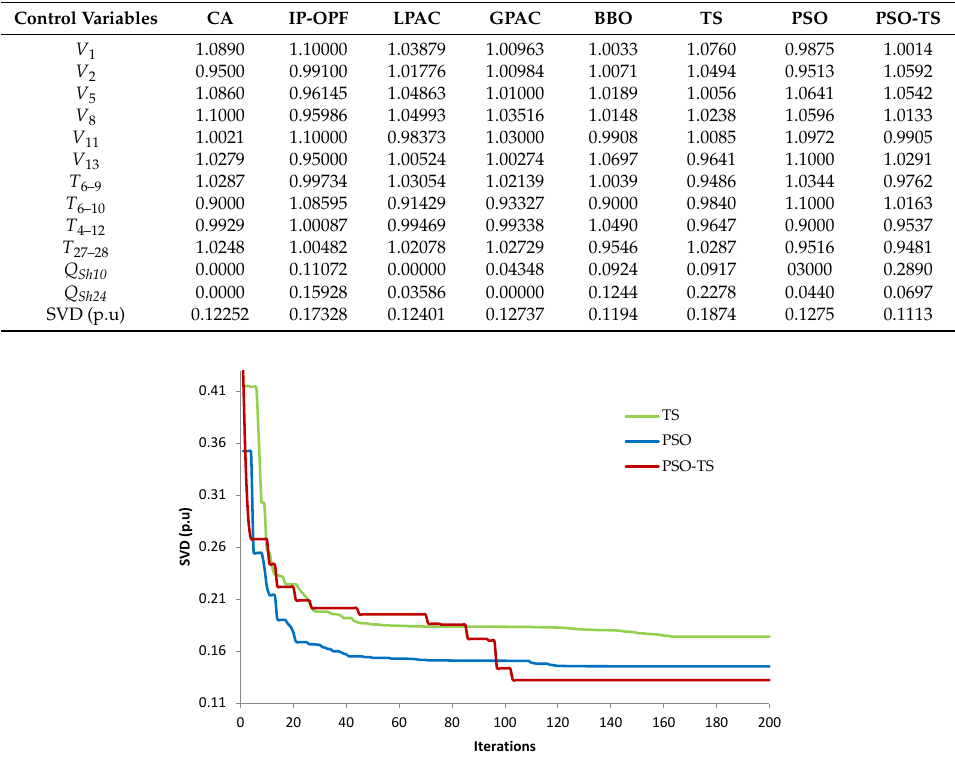
Table 3. Experimental results of TS, PSO and PSO-TS algorithms (Case 1).